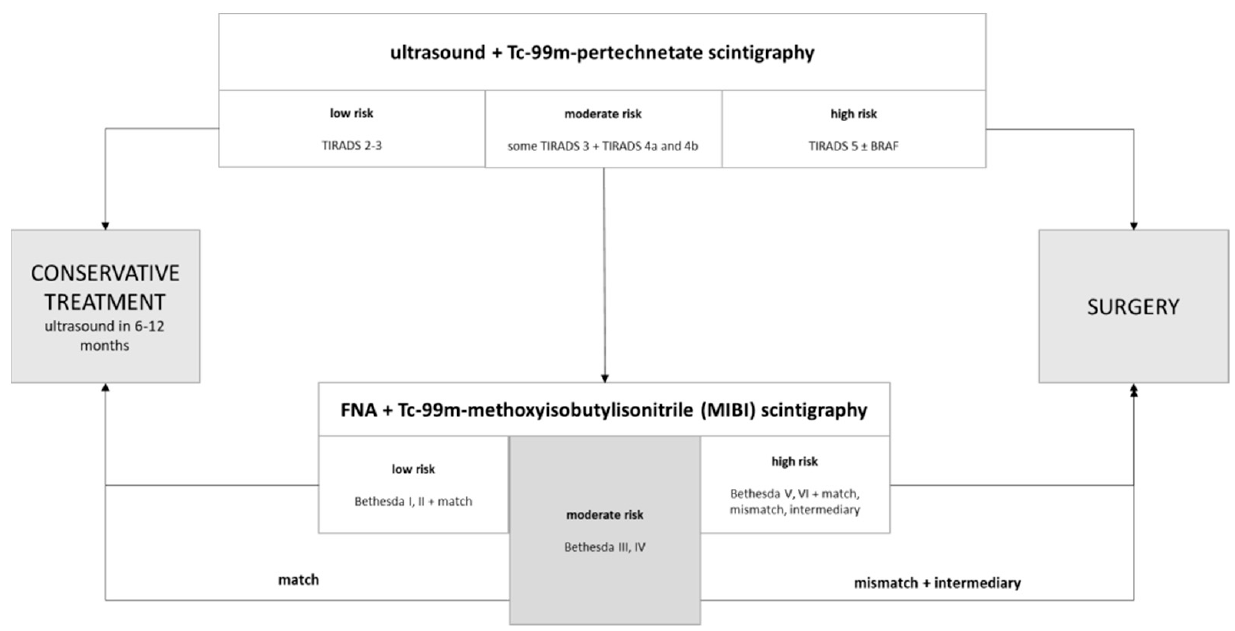
Figure 2. Diagnostic workflow for hypofunctional thyroid nodules. MIBI match results might obviate the need for surgical treatment of indeterminate cytological categories Bethesda III and IV in thyroid nodules with moderate sonographic risk of malignancy.